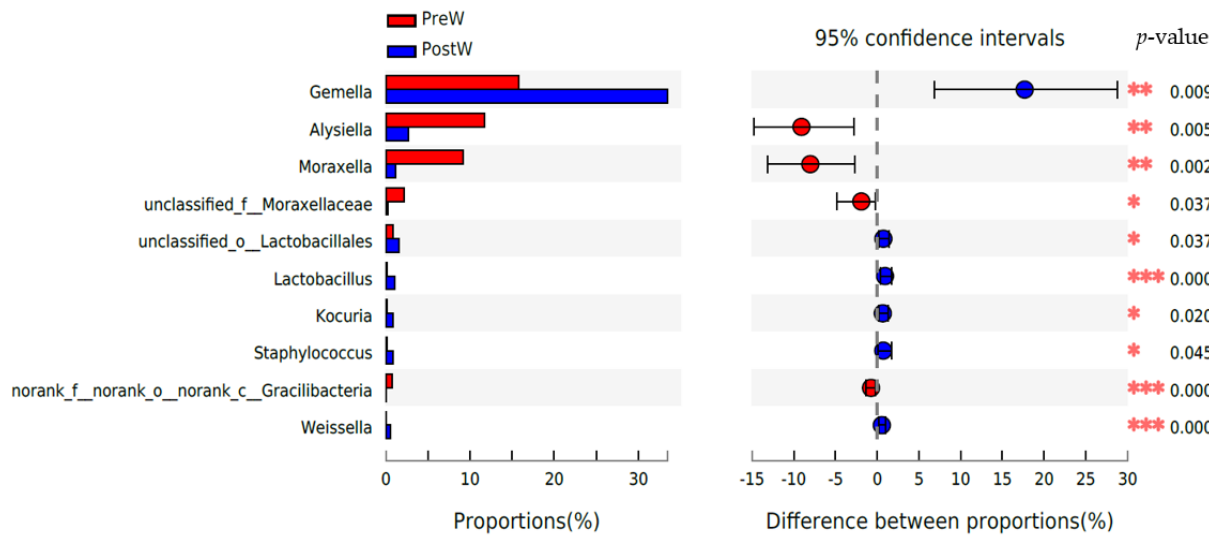
Figure 6. Difference in the predominant oral bacteria at genus level between preweaning and post- weaning donkeys (abundance of the genera was expressed as %). Extended error bar plot was cre- ated by bioinformatics software (STAMP). Welch’s two - sided test was used and Welch’s invert ed was 0.95; PreW, preweaning group; PostW, postweaning group. *, p < 0.05; **, p < 0.01; ***, p < 0.001.